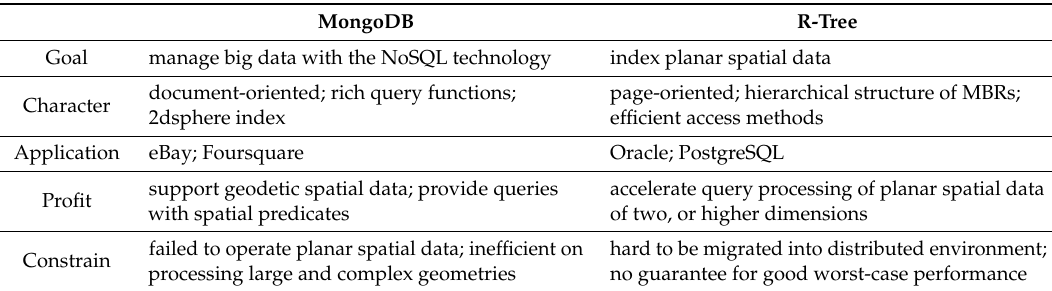
Table 1. A comparison of MongoDB and